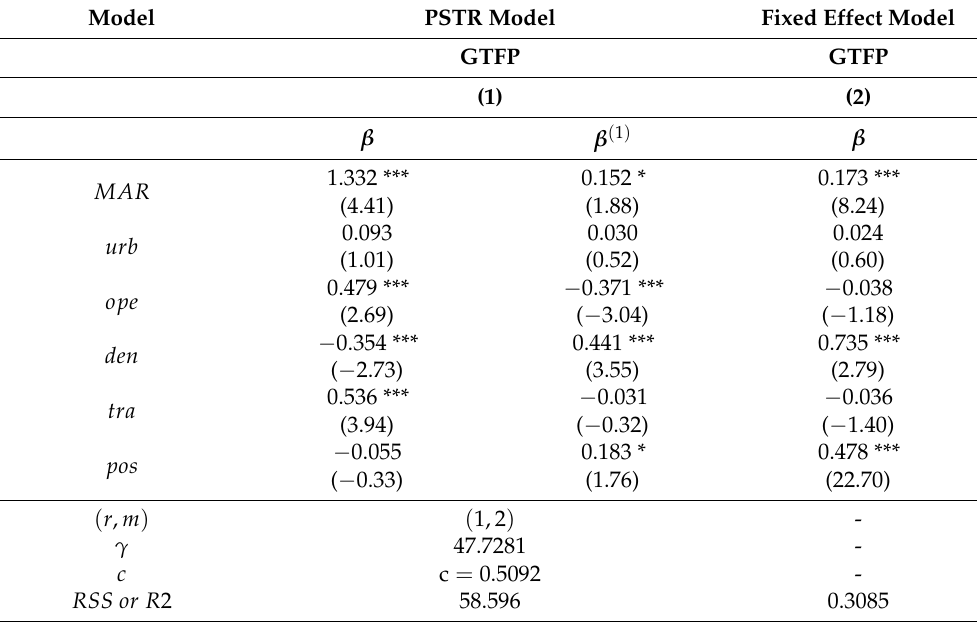
Table 6. Empirical results of MAR based on the PSTR